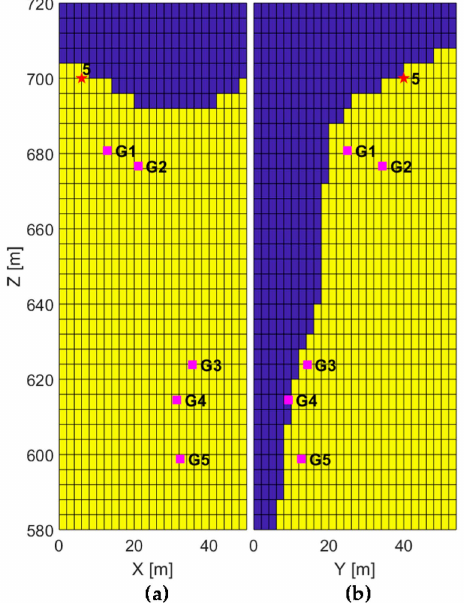
Figure 13. Location results for Fracture event 5 (Rockfall) presented on vertical slices in the front view ( a ) and side view ( b ). The blue area is the air, and the yellow area is rock mass. Pink squares indicate the five 3C geophones projected on the slice. Red stars indicate the event locations projected on the